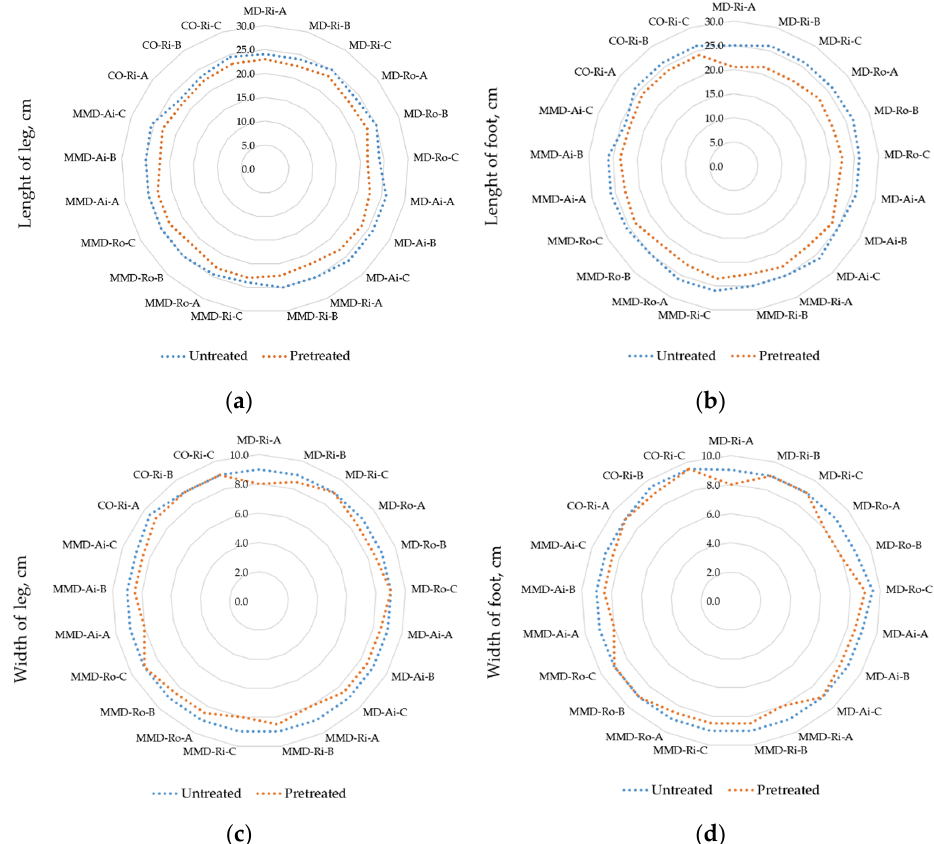
Figure 13. Measured sock dimensions: ( a ) length of the leg part; ( b ) length of the foot part; ( c ) width of the leg part; ( d ) width of the foot part of the untreated and pretreated socks determined before and after five repeated washing and drying cycles (where MD—modal fibers, MMD—micro modal fibers, CO—cotton fibers; Ri—ring spun yarn, Ro—rotor spun yarn, Ai—air ‐ jet spun yarn; A, B, C—sock group). Table 8. Dimensional stability of the socks after five pretreatment cycles.